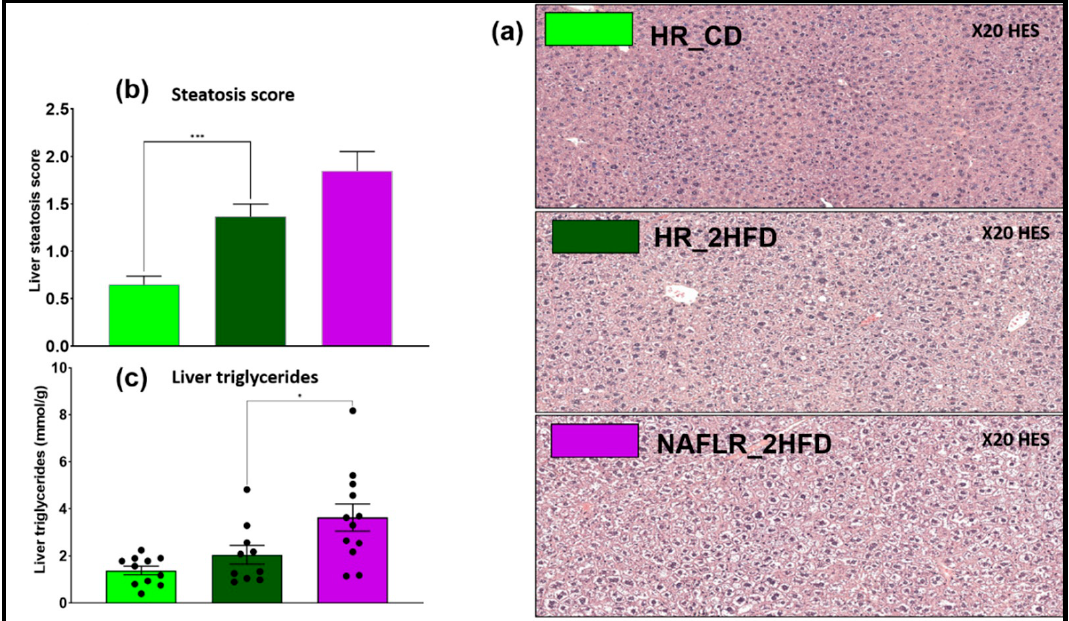
Figure 6. Liver steatosis analysis of CD- and 2HFD-fed HR vs. NAFLR mice, n = 10–12 mice/group. ( a ) Liver hematoxylin-